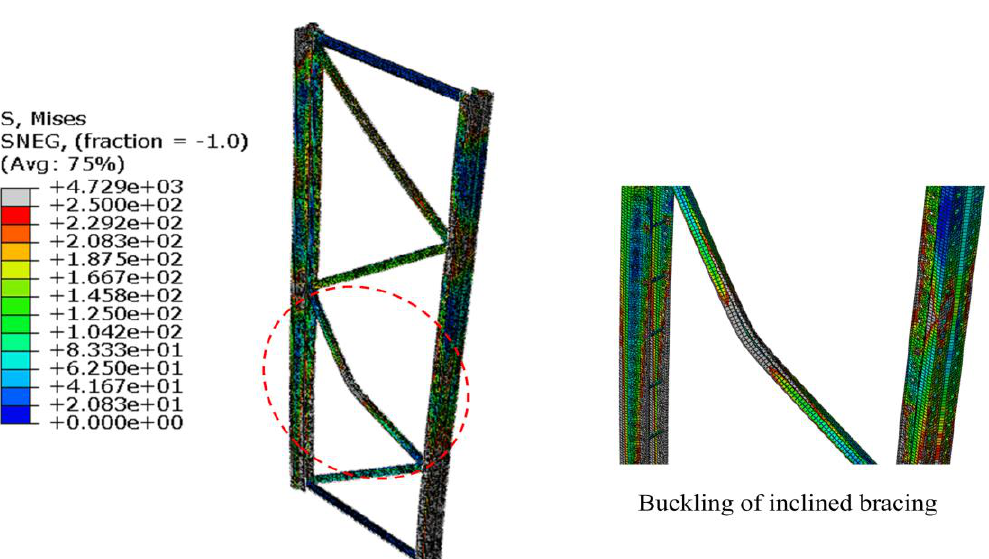
Fig. 13. B1-200-1.6 mm MW frame von Mises stress contours at an instant of maximum top